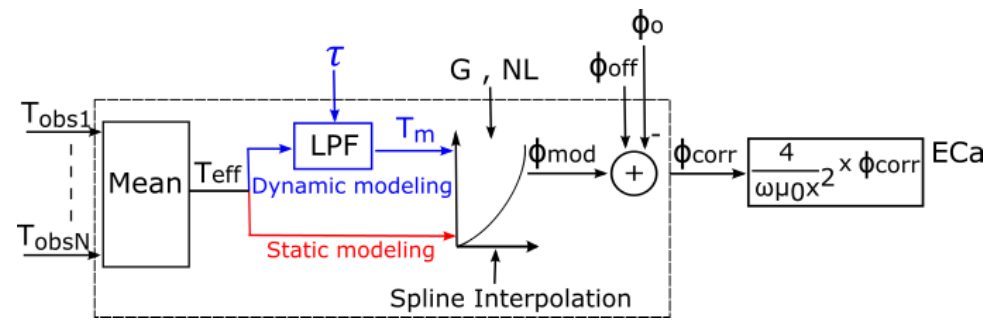
Figure 4. Schematic overview of the phase drift model. The mean T eff of the selected observed tem- peratures T obs1 to T obsN is used as input for the low-pass filter (LPF). The LPF output is a modeled temperature T m , which is converted into a phase ϕ mod by spline interpolation with three reference points. ϕ mod is subtracted from the observed phase ϕ o and gives the corrected phase ϕ corr , which is converted to ECa by the McNeill [12] approximation. The system’s offsets are also considered by including a parameter ϕ off . The inclusion of the LPF results in dynamic modeling (blue path) and bypassing the LPF results in static modeling (red path), whereby phase calibration is done by the look-up table alone.